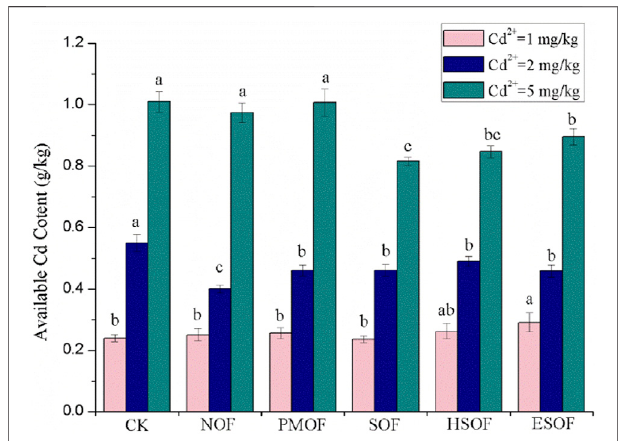
FIGURE 1 | The effect of organic fertilizer types on the contents of available Cd in soils with different Cd loads (The letter on the bar shows the statistical differences between treatments at p <